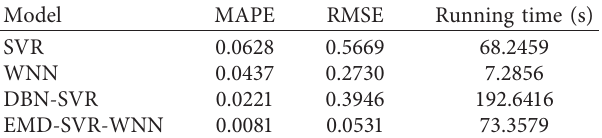
Table 3: Performance comparison of different prediction models.